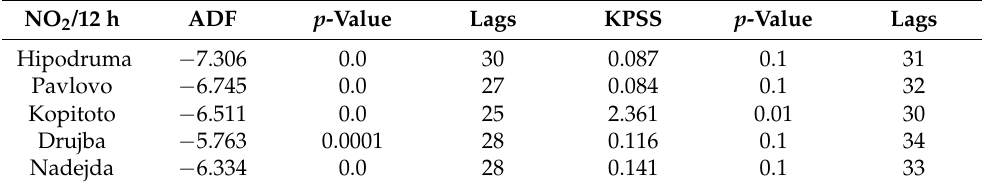
Table 8. Values of the ADF and KPSS tests applied on the NO 2 dataset for granularities: 12